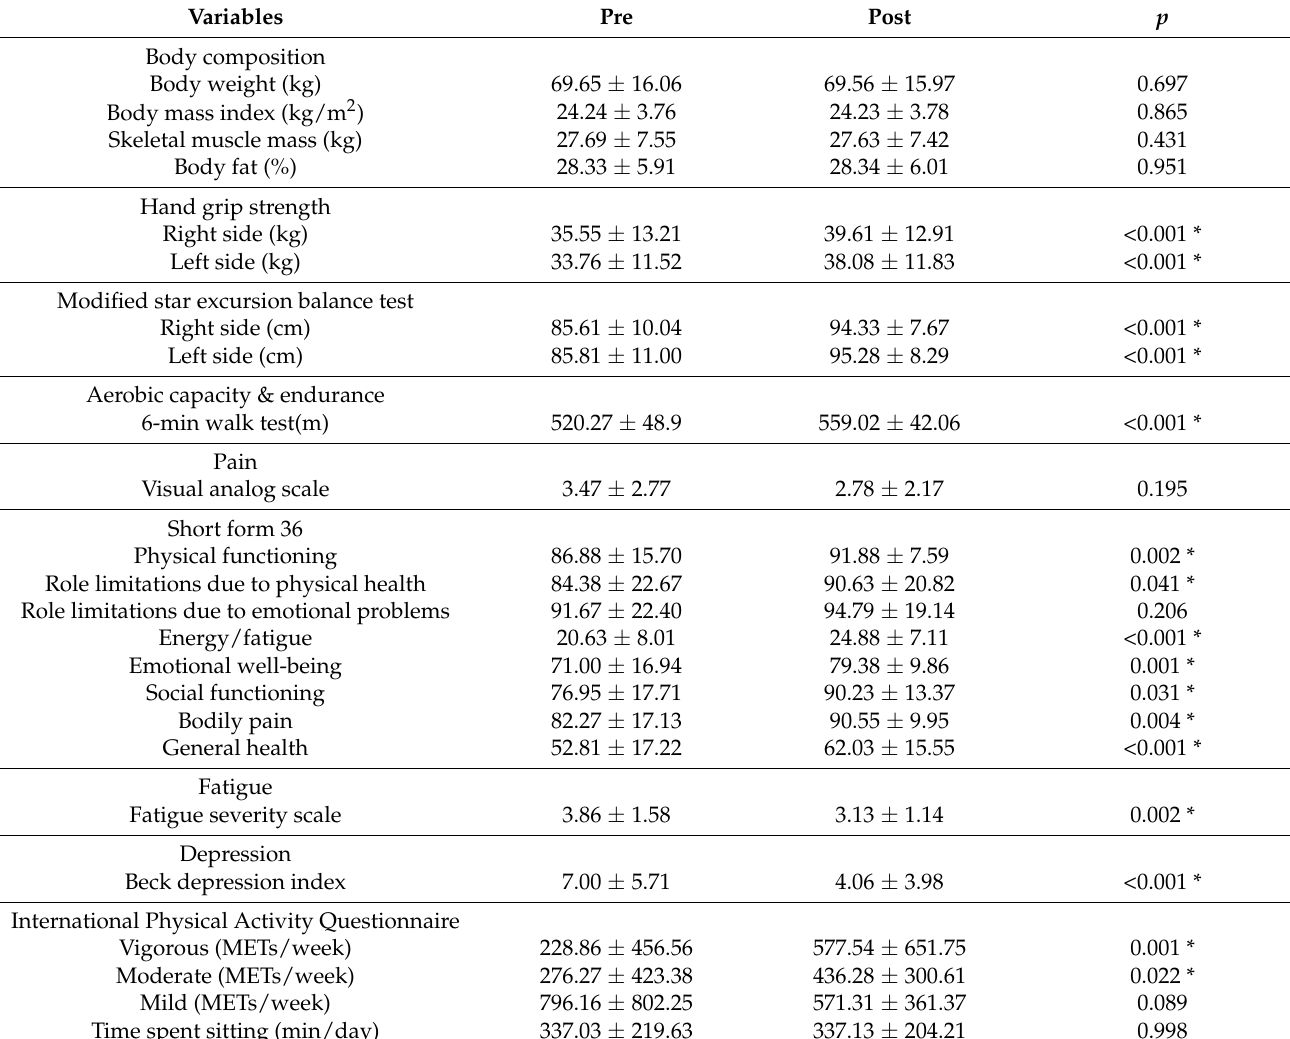
Table 3. Comparison between pre- and post-intervention physical and psychological statuses.